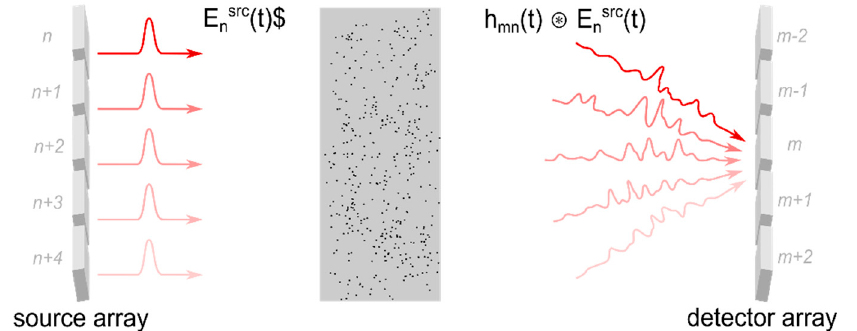
Figure 10. Coupling of temporal and spatial degrees of freedom in a scattering medium. Illuminating a sample with varying spatial modes causes different spatial (not shown, see Figure 5) and temporal speckle profiles to be observed behind a turbid sample. Spatial shaping of the incident beam enables temporal manipulation of the scattered field. Image from [8], with permission.